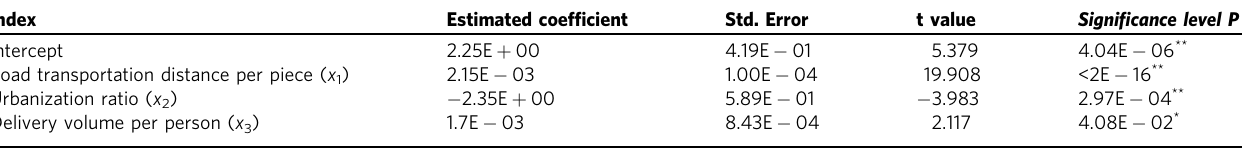
Table 1 Stepwise regression for GHG emissions from express deliveries with various